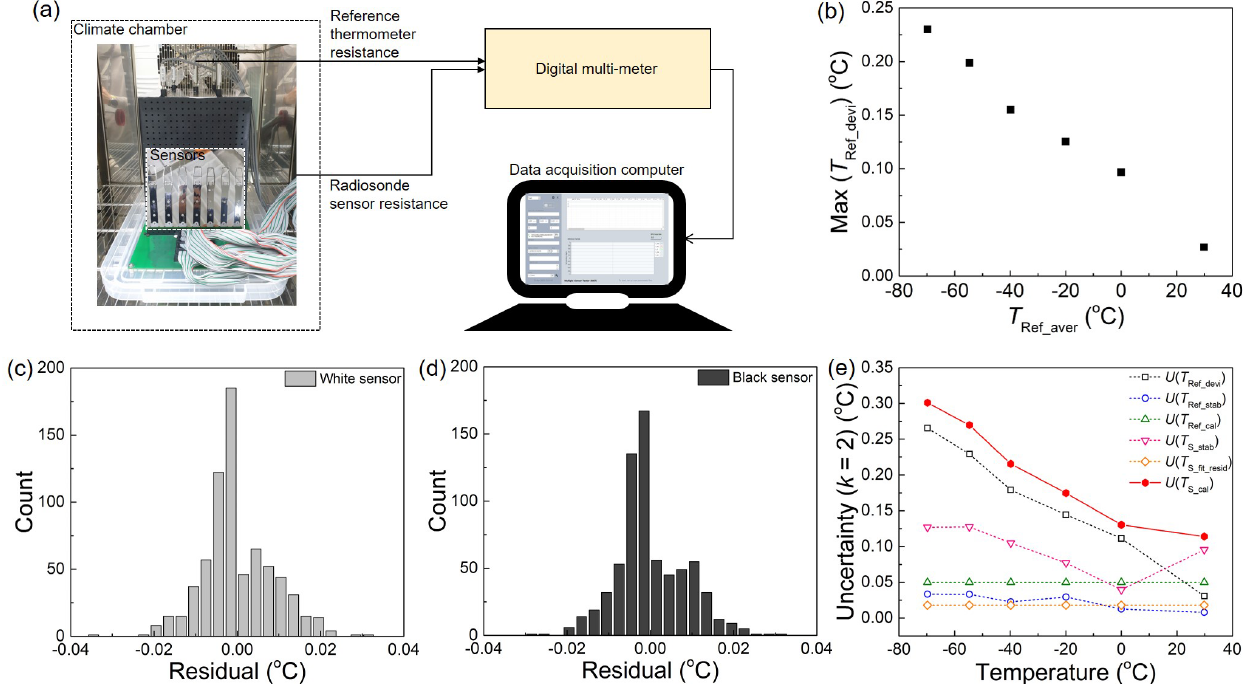
Figure 3. Calibration of individual thermistors in a climate chamber. (a) Calibration setup showing thermistors on booms (left), a digital multimeter to read the sensor resistance (top right) and a data acquisition computer (bottom right). (b) Maximum temperature deviations ( T Ref_devi ) with respect to the average of five reference thermometers ( T Ref_aver ) as a function of T Ref_aver . Distribution of the residuals of the (c) white and (d) black sensors by individually applying the calibration curves. (e) The uncertainty budget on the radiosonde ther- mistor calibration, U(T s_cal ) , with a coverage factor k = 2. Uncertainty factors including reference temperature deviations U(T Ref_devi ) , stability U(T Ref_stab ) and calibration U(T Ref_cal ) , radiosonde sensor stability U(T s_stab ) and fitting residual U(T s_fit_resid ) are considered for U(T s_cal )